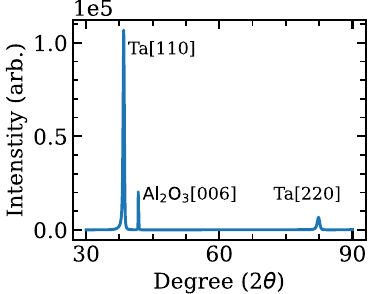
Fig. 6 XRD spectrum of a Ta fi lm on sapphire. Two clear peaks correspond to [110] and [220] of the alpha phase of Ta, and the peak in the middle corresponds to the sapphire substrate we XPS to obtain chemical elements of Ta fi lm surface. The two peaks tantalum metal, and the two peaks at higher binding energy correspond to the same orbitals of Ta 2 O 510 . We do not see any other chemical components, which indicates that Ta 2 O 5 is the only surface oxide of Ta fi lms. From our results, it can be seen that